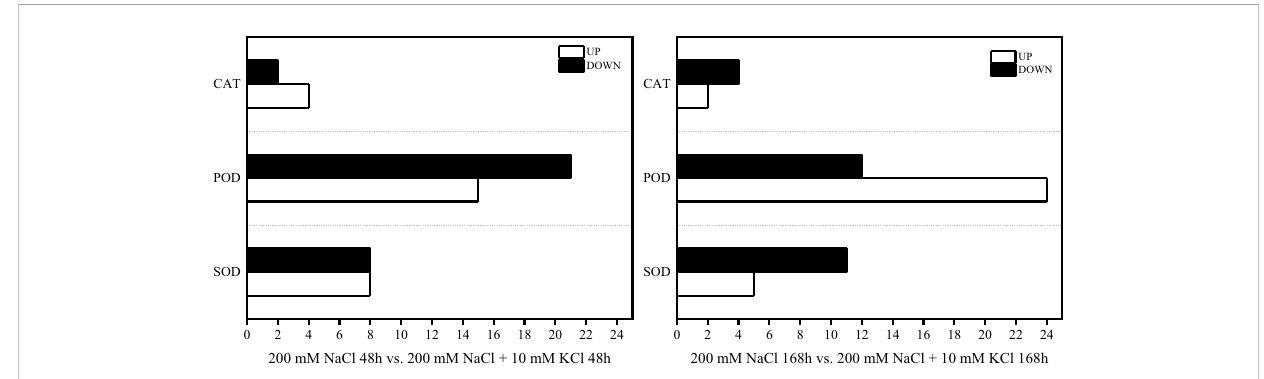
FIGURE 4 Statistical chart of the expression number of key genes of antioxidant enzymes in the roots of T . ramosissima with exogenous K + applied under NaCl stress. (58 SOD, POD, CAT activities-related differences in the 200 mM NaCl 48h vs. 200 mM NaCl + 10 mM KCl 48h and 200 mM NaCl 168h vs. 200 mM NaCl + 10 mM KCl 168h comparison groups expressed genes were annotated to the KEGG pathway, and we counted the changes in the expression levels of these 58 DEGs in the 200 mM NaCl 48h vs. 200 mM NaCl + 10 mM KCl 48h and 200 mM NaCl 168h vs. 200 mM NaCl + 10 mM KCl 168h comparison